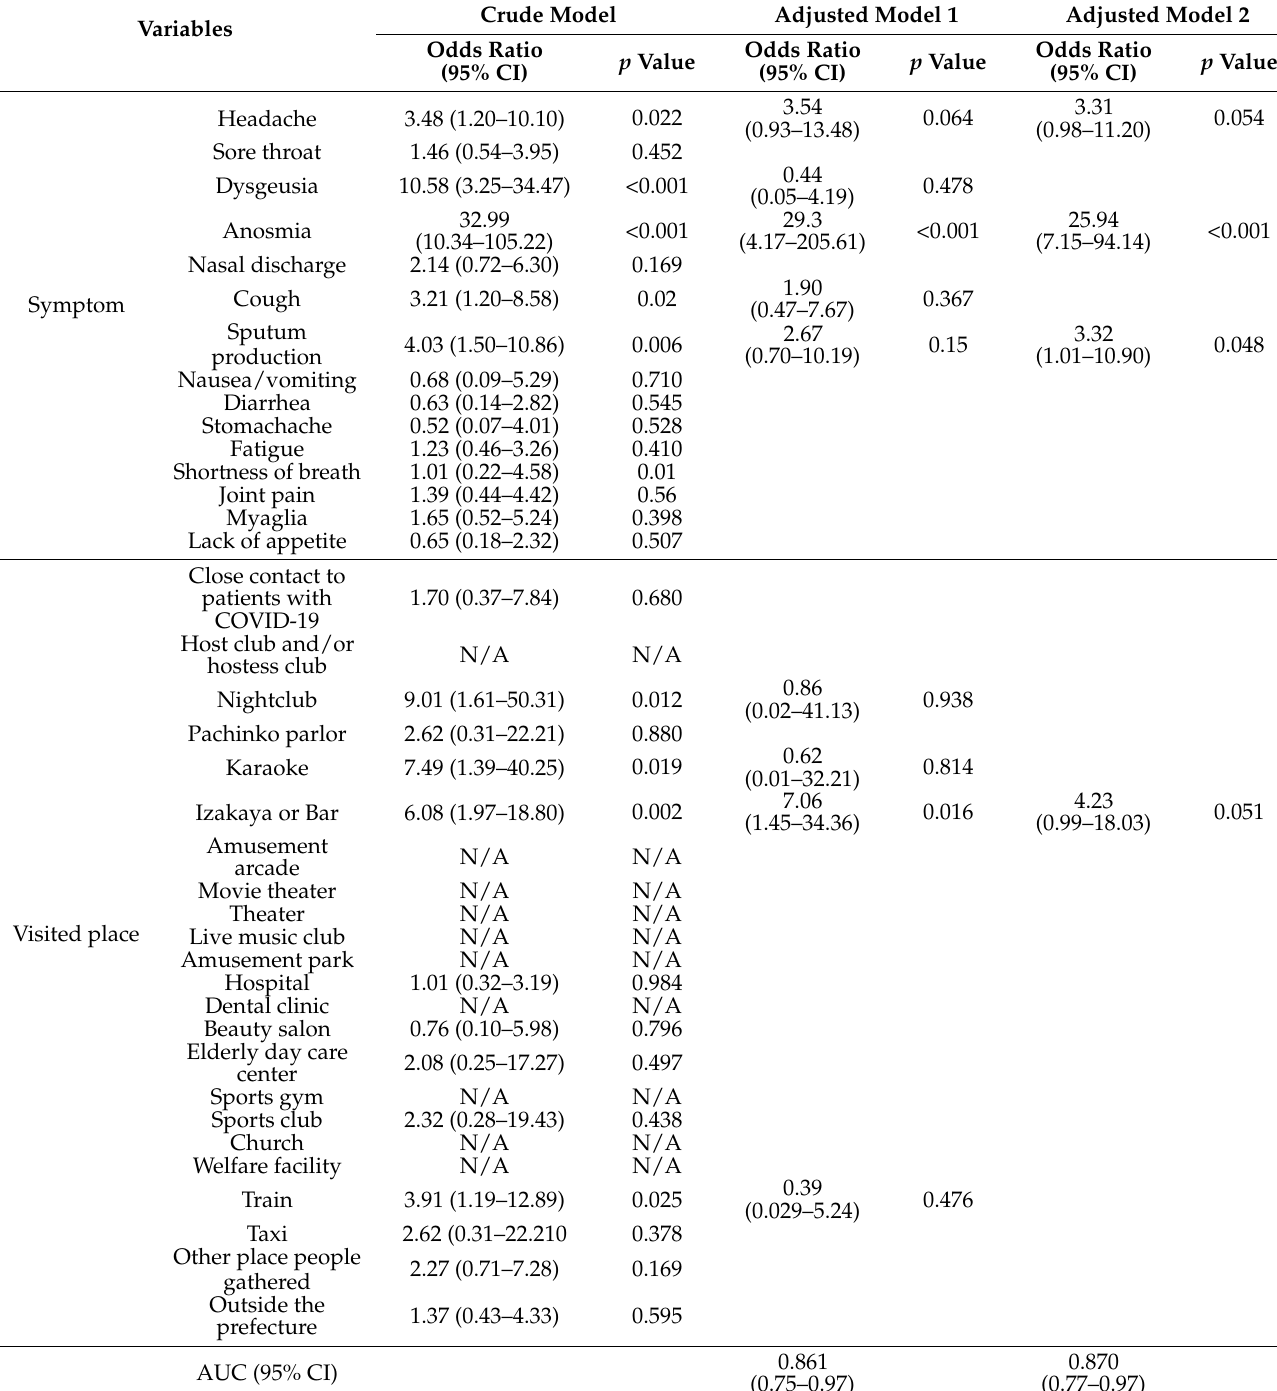
Table 3. Crude odds and adjusted odds ratios and 95% confidence intervals of risk factors for